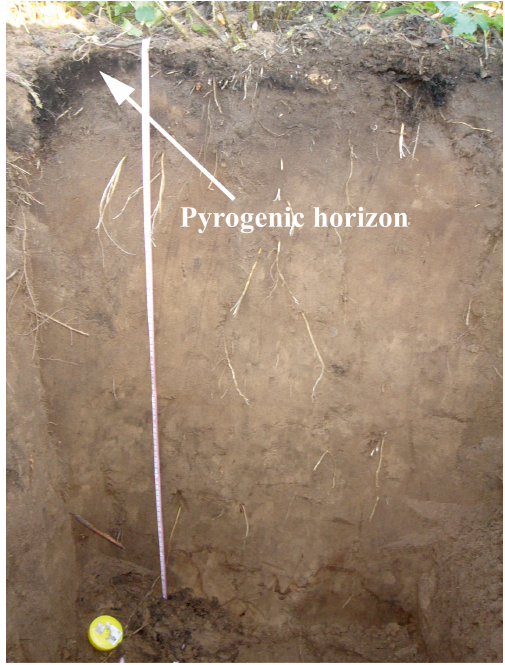
Figure 1. Crown fire-affected soil. Figure 2. Surface fire-affected